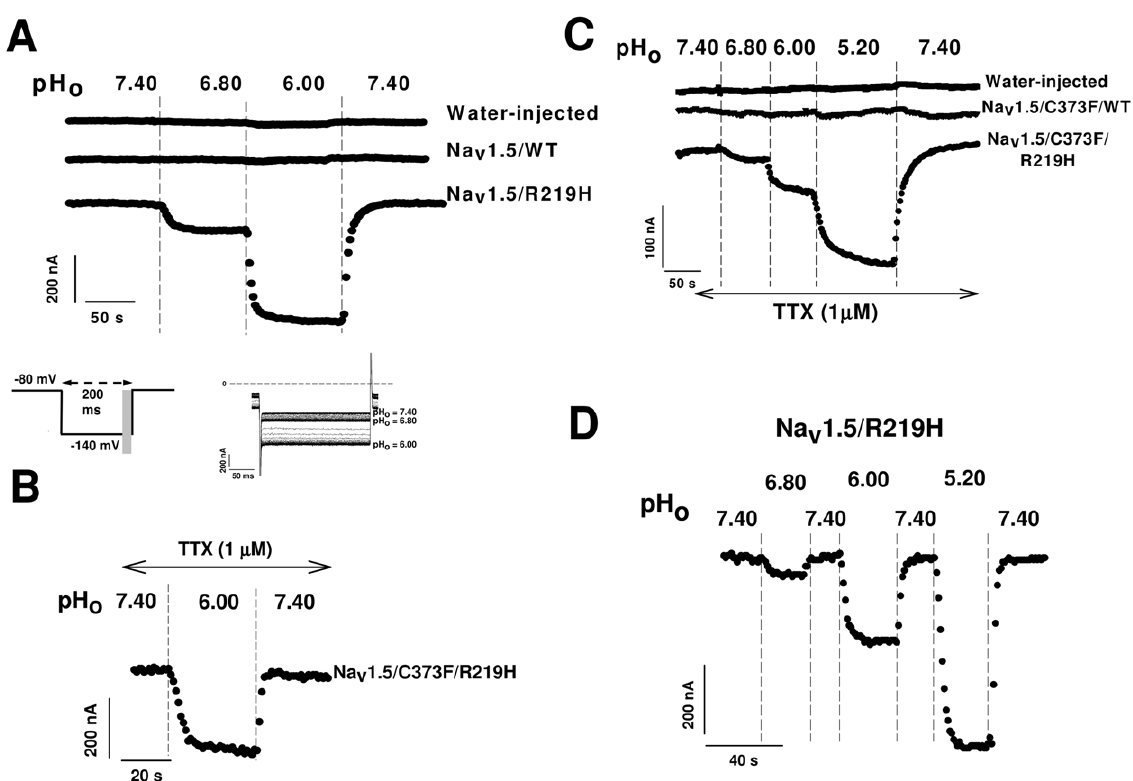
Figure 3. Na v 1.5/R219H exhibits a pH dependent current. Panel ( A ) shows that varying the Ringer’s extracellular pH (pH o ) induced an inward current in Na v 1.5/R219H–injected oocytes. An acidic Ringer’s solution induced inward currents in an oocyte expressing the Na v 1.5/R219H channel. The oocyte was held at 2 80 mV and a 2 140 mV test pulse was repeated every 2 s (only current responses at 2 140 mV are shown). The bottom panels show current traces of the experiment in ( A ). The inset shows the protocol, and the grey zone indicates where currents were measured as a mean of the current amplitude between 150 and 200 ms.( B ) Effect of an acidic Ringer’s solution in the presence of TTX in an oocyte expressing the Na v 1.5/R219H mutant channel in a background in which the native cysteine in D1 had been replaced with a tyrosine (C373F) and in the presence of 1 m M TTX. This mutation in the pore region increases the TTX sensitivity of cardiac channels 60- to100-fold, as described previously [46]. ( C ) Currents recorded from a water-injected and oocyte expressing the Na v 1.5/WT or Na v 1.5/R219H channel. The oocytes were held at 2 80 mV and were pulsed to 2 140 mV. This protocol was repeated every 2 s as indicated in the inset ( panel A ). Acidic NMDG solutions induced a pH-dependent current in an oocyte expressing the Na v 1.5/R219H channel in a C373F background in the presence of 1 m M TTX. This experiment was carried out in a Na v 1.5 background in which the native cysteine in D1 was replaced with a tyrosine (C373F). ( D ) Acidic NMDG solutions induced a reversible current in an oocyte expressing the Na v 1.5/R219H channel.